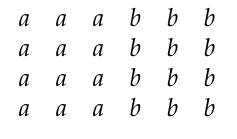
Figure 1. A picture array in the language L 1